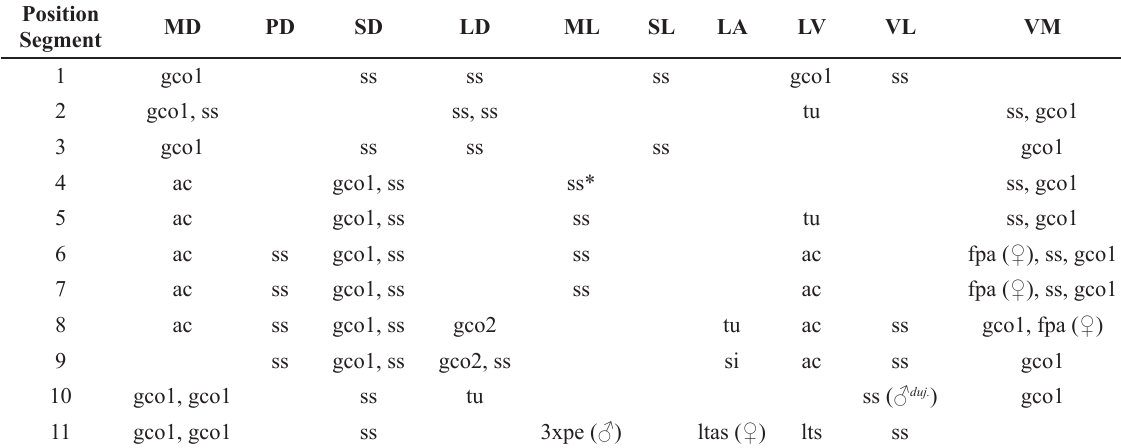
Table 4. Summary of nature and location of sensory spots, glandular cell outlets, tubes and spines arranged by series in Echinoderes dujardinii Claparède, 1863 and E. gerardi Higgins,